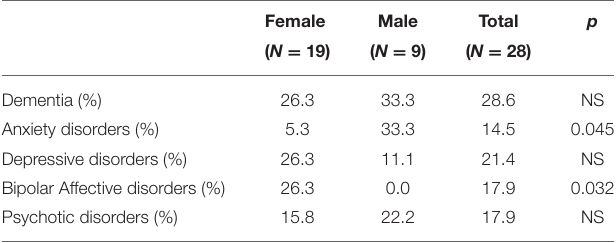
TABLE 2 | Initial psychiatric diagnostics.